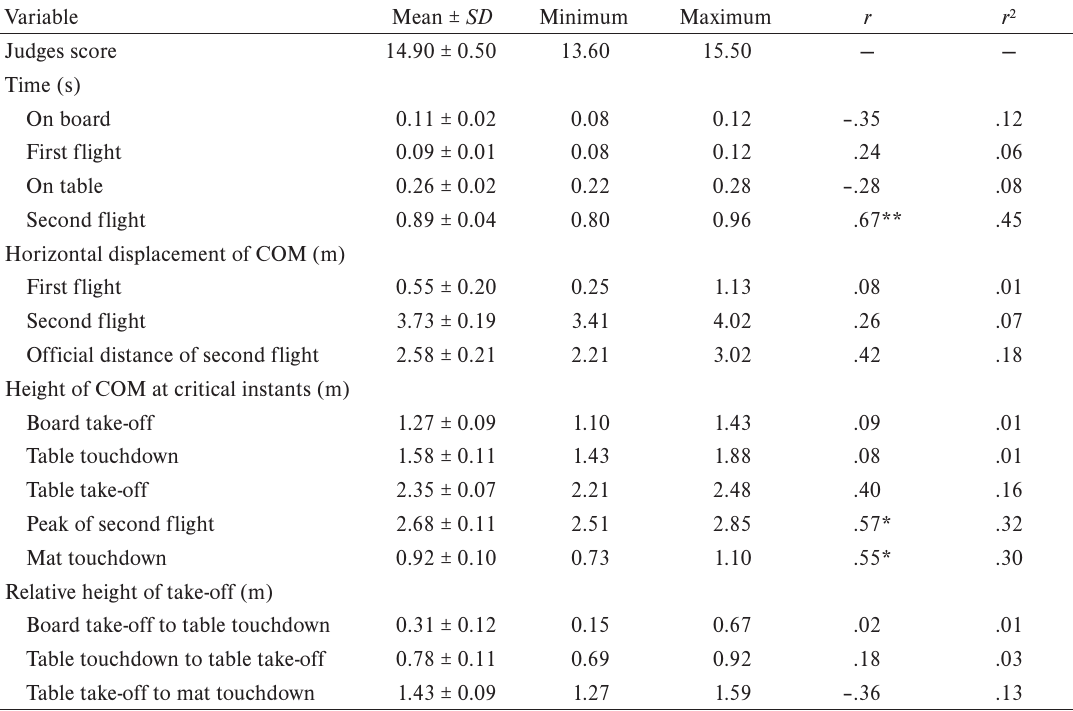
Table 1 Relationship between temporal and spatial variables and the judges’ score in critical phases of the vault (N = 15) Variable Mean ± SD